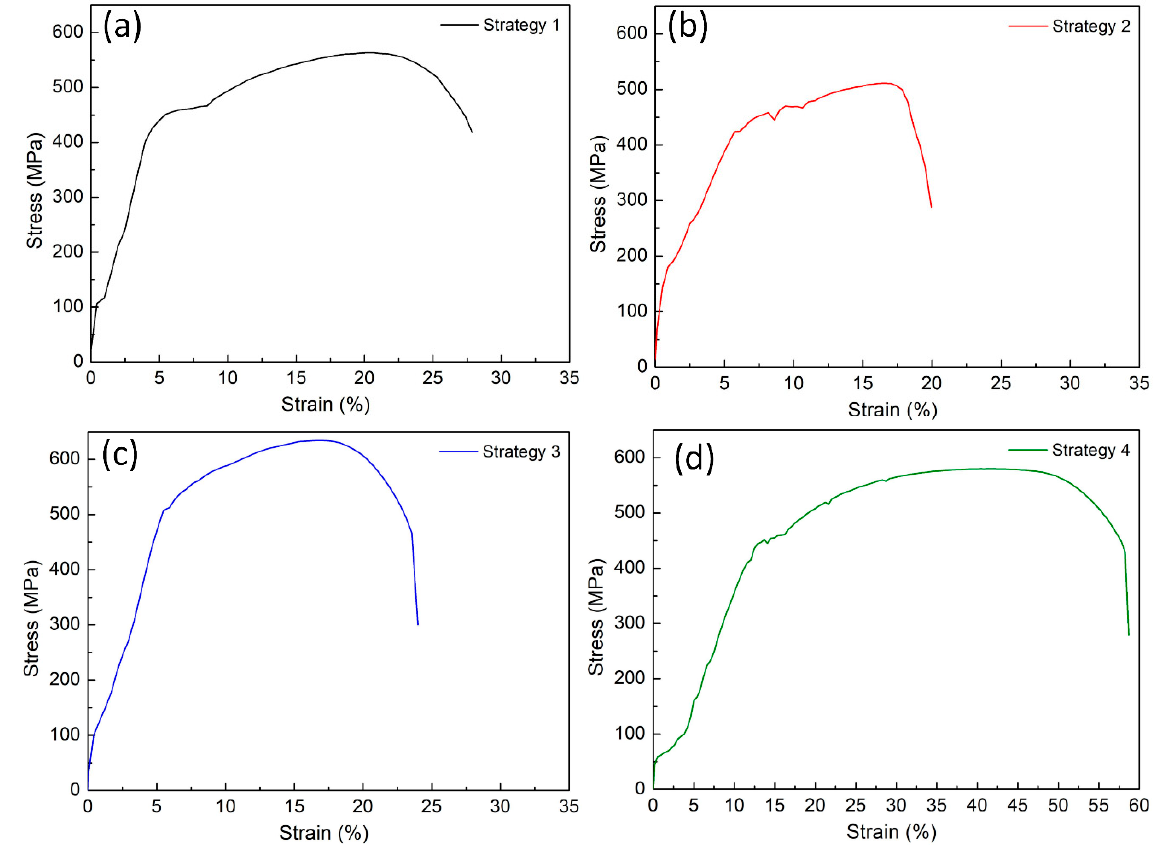
Figure 4. Stress-strain diagrams of samples at different WAAM strategies: ( a ) strategy 1, ( b ) strategy 2, ( c ) strategy 3, and ( d ) strategy 4.